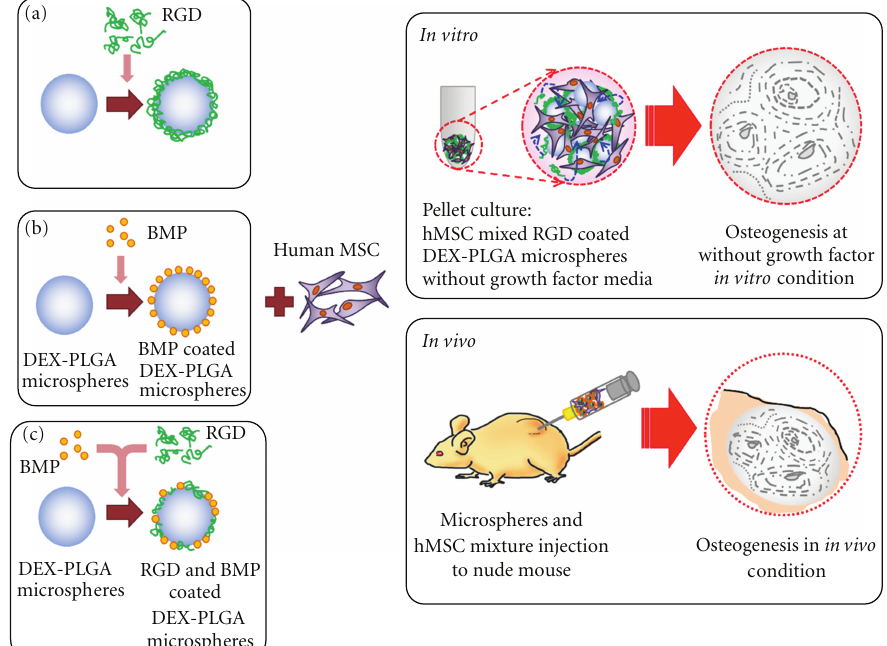
Figure 3: Schematic diagram of RGD-modified PLGA microspheres containing growth factors and dexamethasone. Using a layer-by-layer (LBL) technique, positively charged, PEI precoated PLGA microspheres coated with negatively charged RGD molecules were fabricated for hMSC delivery and regeneration of injured tissues. The combination of growth factors, DEX, and RGD was an e ff ective sca ff old for cell delivery and di ff erentiation of embedded hMSCs